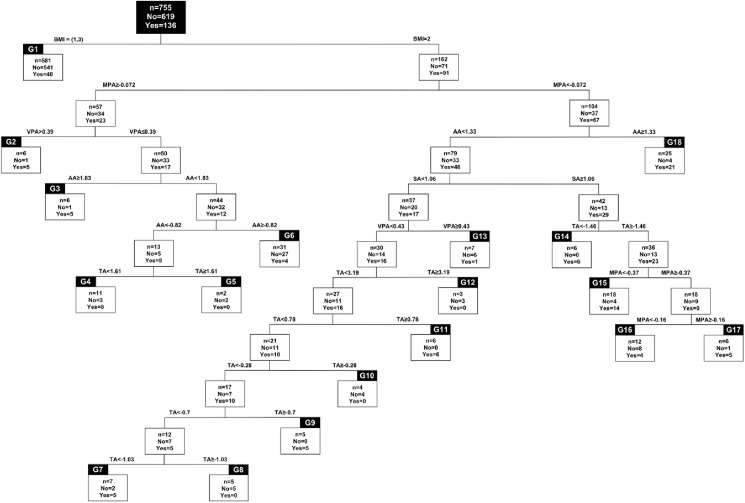
Classification tree.